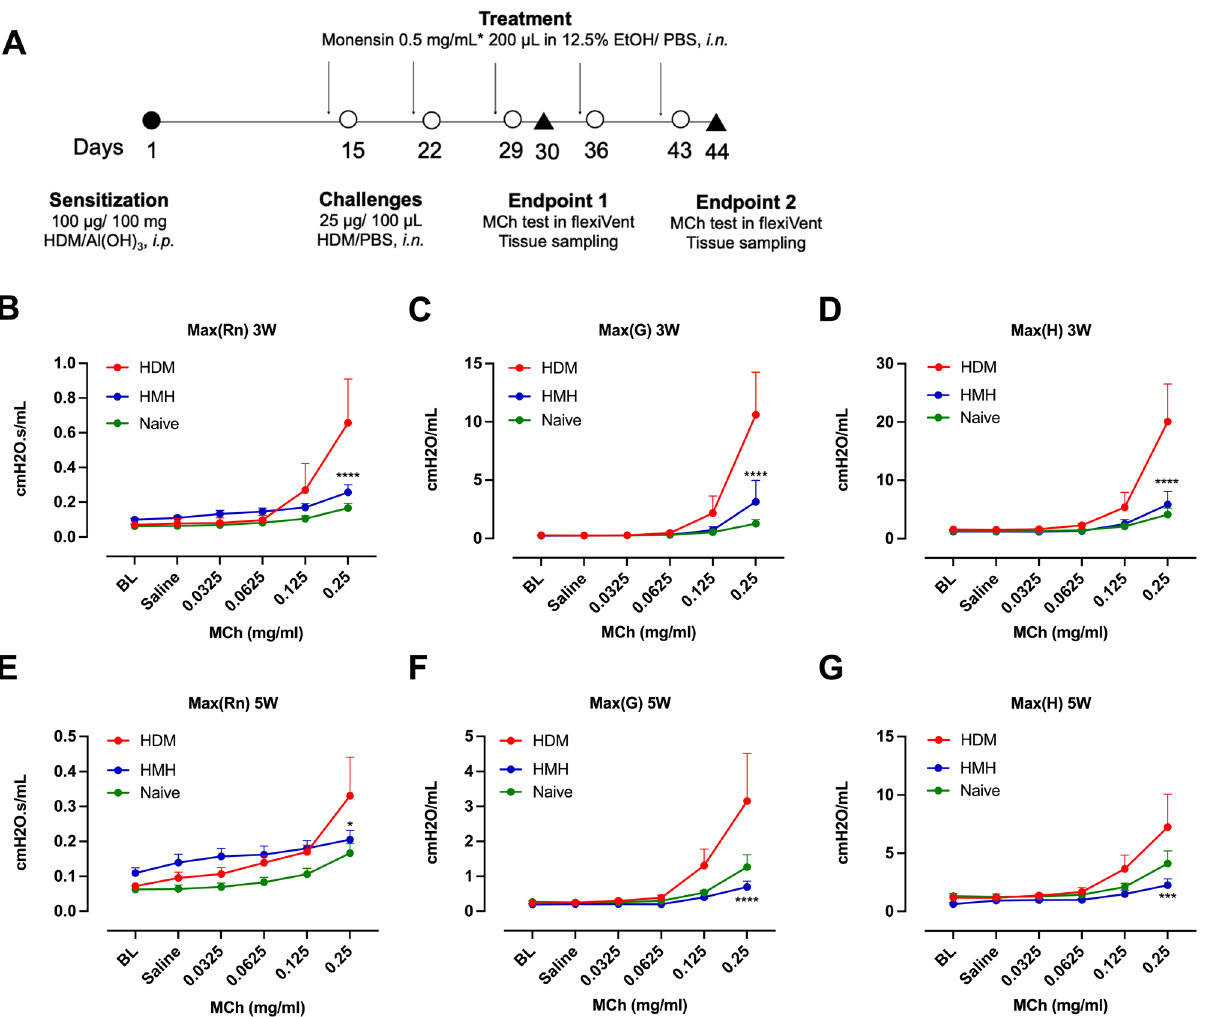
Figure 6. Effect of monensin on airway hyperresponsiveness. ( A ) Schematic diagram of the guinea pig asthma model. Animals were sensitized with a single i.p. injection of HDM + adjuvant followed by intranasal HDM challenges for three or five weeks. Monensin (0.5 mg/mL in 200 µL 12.5%EtOH/PBS) was given 24 h before each challenge. Airway responsiveness to methacholine (MCh) was assessed in a flexiVent system one day after ( B–D ) the third or ( E–G ) the fifth challenge. Differences of resistance in conducting airways ( Rn ; B and E ), tissue damping ( G ; C and F ) and tissue elastance ( H ; D and F ) were compared between the animals exposed to HDM with or without monensin treatment (n = 4–7 per group). Control: animals exposed to PBS, received vehicle (12.5% EtOH) or monensin as pretreatment. HDM: animals exposed to HDM and received vehicle